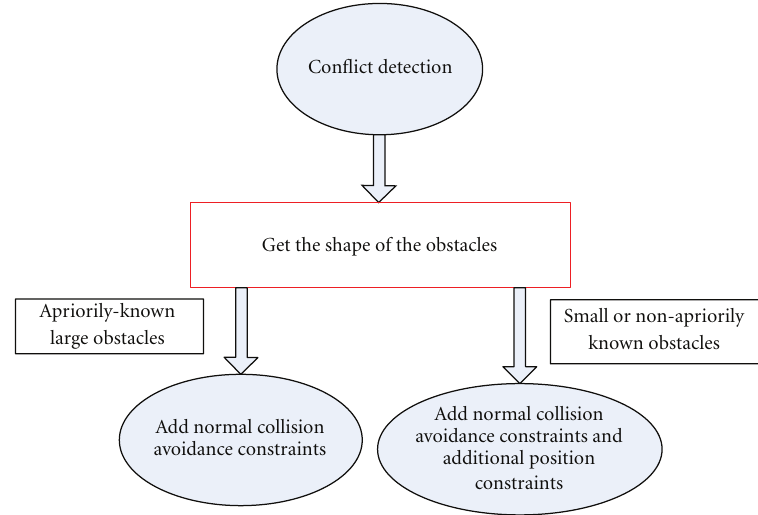
Figure 6: Collision avoidance flow chart.